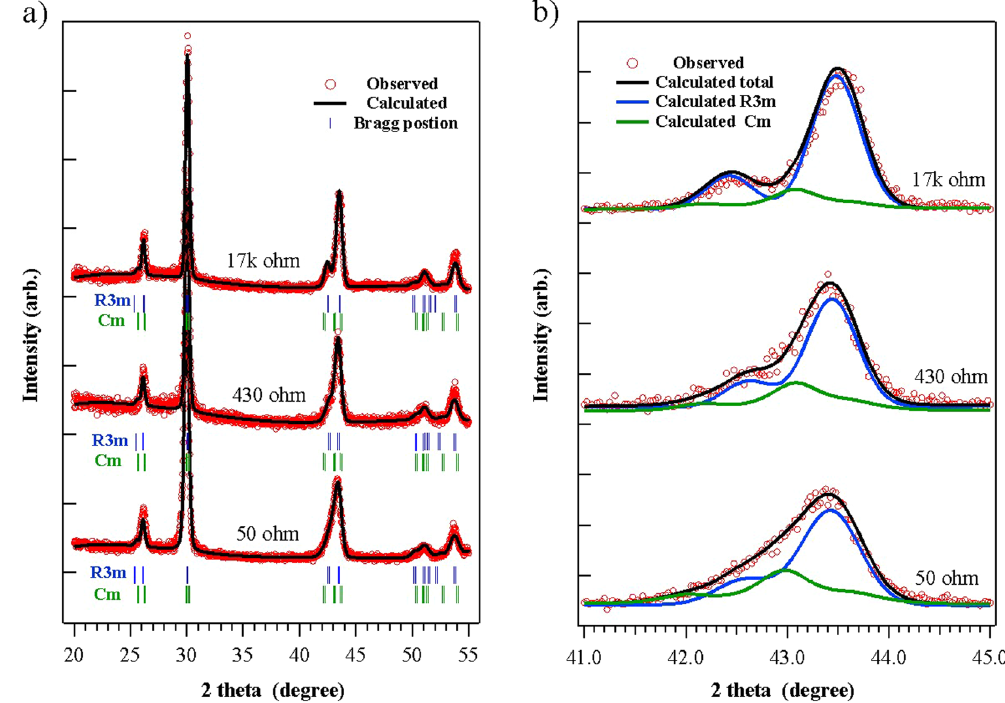
Figure 4. ( a ) Experimentally measured and calculated (Rietveld method) XRD spectra for annealed and laser-irradiated GeTe films. ( b ) Measured and calculated XRD spectra in the range between 40° and 46°. XRD spectra of crystalline samples contain peaks from the R3m (P1), and Cm structures. Samples subjected to laser irradiation had decreased Cm peak intensity and increased